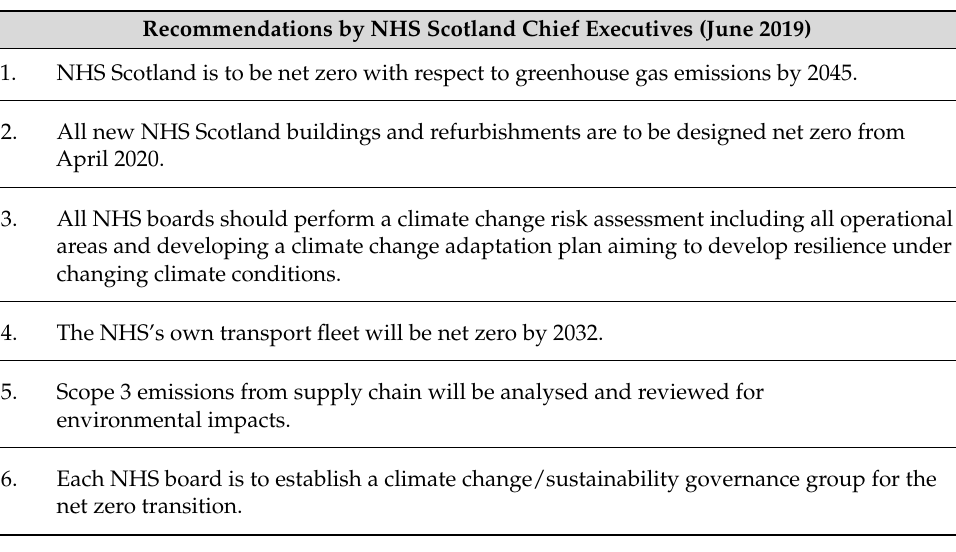
Table 1. The six high-level commitments of NHS